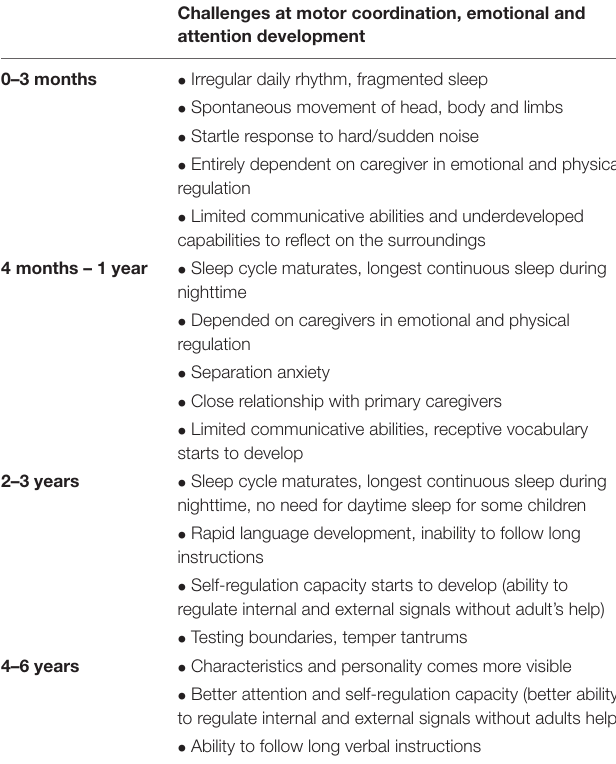
TABLE 2 | Challenges at motor coordination, emotional and attention development in a different age